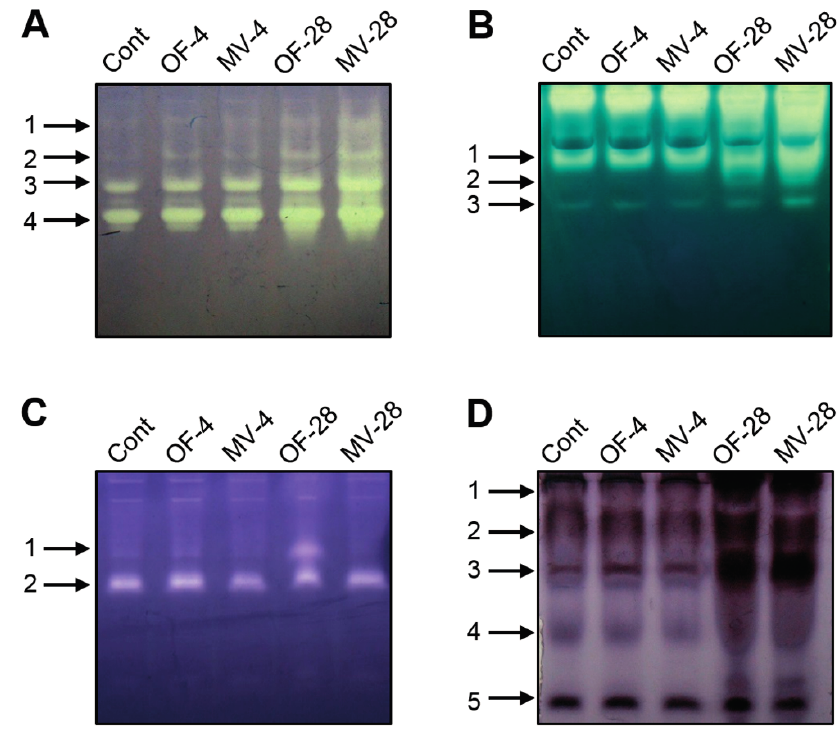
Figure 3. Profiles of antioxidant isozymes in rice plants with the foliar application of OF or MV treatment. ( A ) Superoxide dismutase; ( B ) Catalase; ( C ) Ascorbate peroxidase; and ( D ) Peroxidase. Non-denaturing activity gels were prepared and run as described in the method. The plants were subjected to the same treatments as in Figure 2. Treatment notations are the same as in Figure 2. The numbers indicate each isozyme of antioxidant enzymes in order of detected bands from the